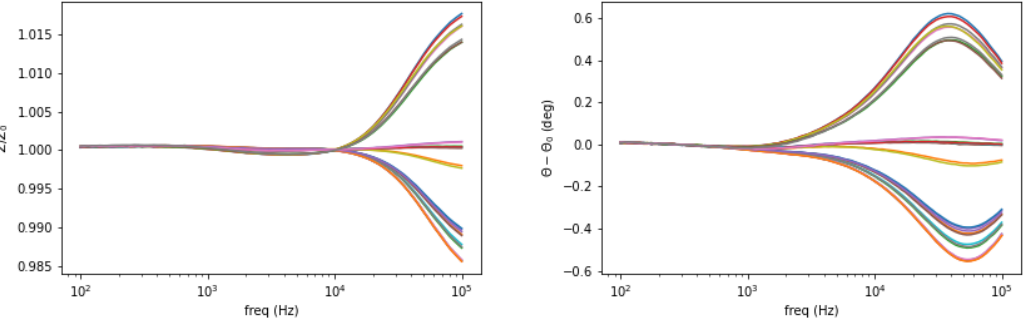
Figure 3. Amplitude ( left ) and phase ( right ) spectrum of a test sample plotted against the background.